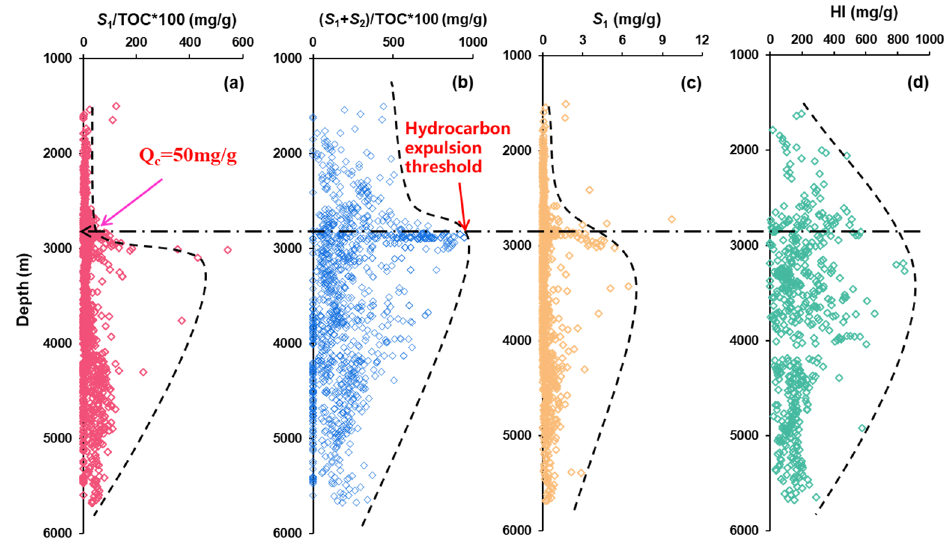
Figure 6. Evolution profile of hydrocarbon generation in shale. ( a ) A relationship of S 1 /TOC with depth; ( b ) a relationship of ( S 1 + S 2 )/TOC with depth; ( c ) a relationship of S 1 content with depth; ( d ) a relationship of HI index with depth.